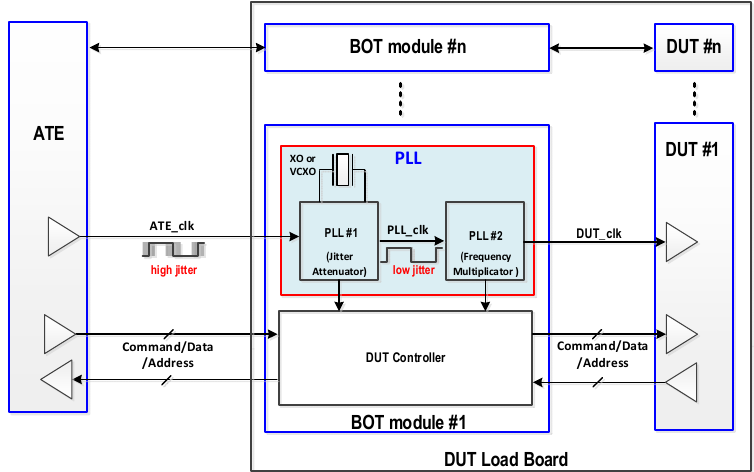
Figure 1. Simplified block diagram of a BOT-based parallel multi-DUT test system.